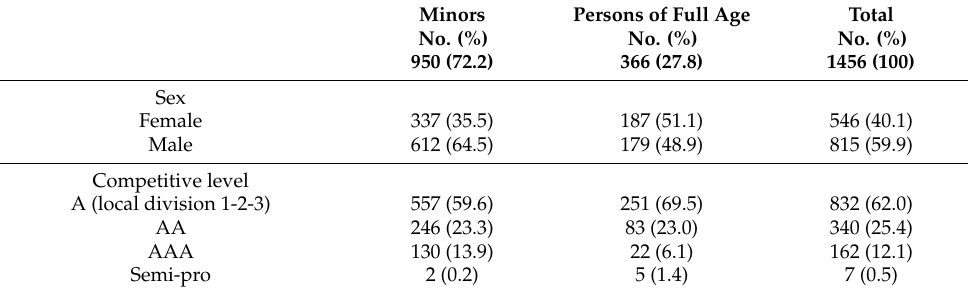
Table 1. Sports profile of participants ( n =